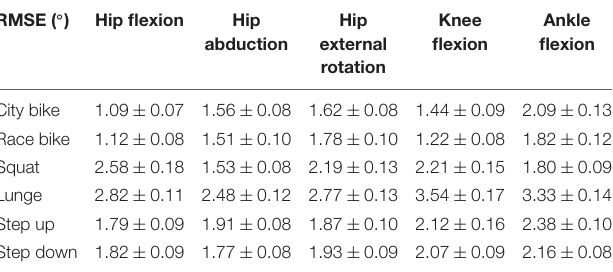
TABLE 2 | Root-mean-square errors (RMSE ± standard deviation) from the kinematic parameterization. RMSE ( ◦